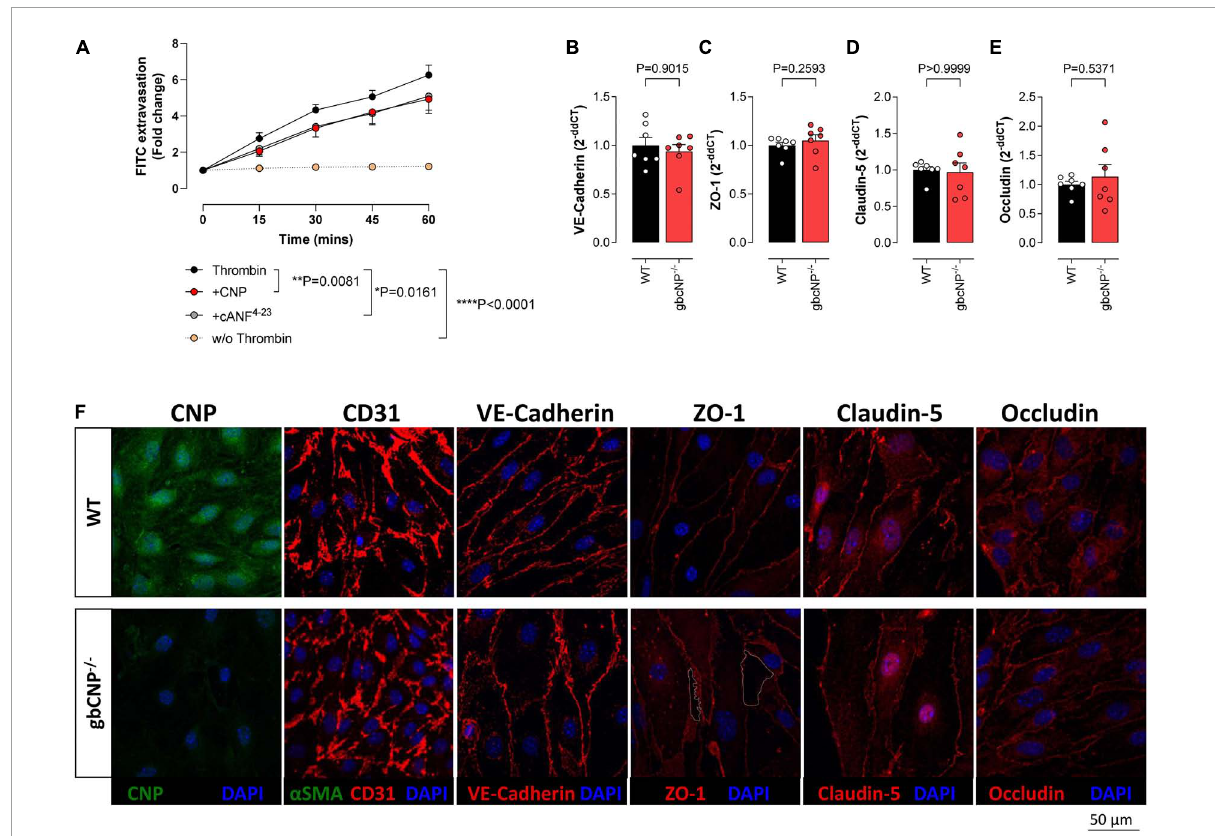
FIGURE7 CNP prevented endothelial cell extravasation via NPR-C signaling. Transwell FITC extravasation from murine brain endothelial cells from wild-type (WT) animals induced by thrombin (5 IU/ml), in the absence and presence of CNP (100 nM) or the NPR-C selective agonist cANF 4 − 23 (100 nM), compared to basal unstimulated extravasation (w/o Thrombin); (A) . mRNA expression of VE-cadherin (B) , Zonula Occludens-1 (ZO-1); (C) , claudin-5 (Cldn5); (D) and occludin (E) , and representative images of C-type natriuretic peptide (CNP), CD31, VE-cadherin, ZO-1, claudin-5 and occludin inmmunohistofluorescence in murine brain endothelial cells from wild-type (WT) and global CNP knockout (gbCNP − / − ) mice (F) . The white dotted line indicates a gap between the cells. n = 5-7. Statistical analysis by two-tailed Student’s t -test, Mann–Whitney U test or two-way analysis of variance with Šídák post hoc test. Each statistical comparison undertaken has an assigned P value (adjusted for